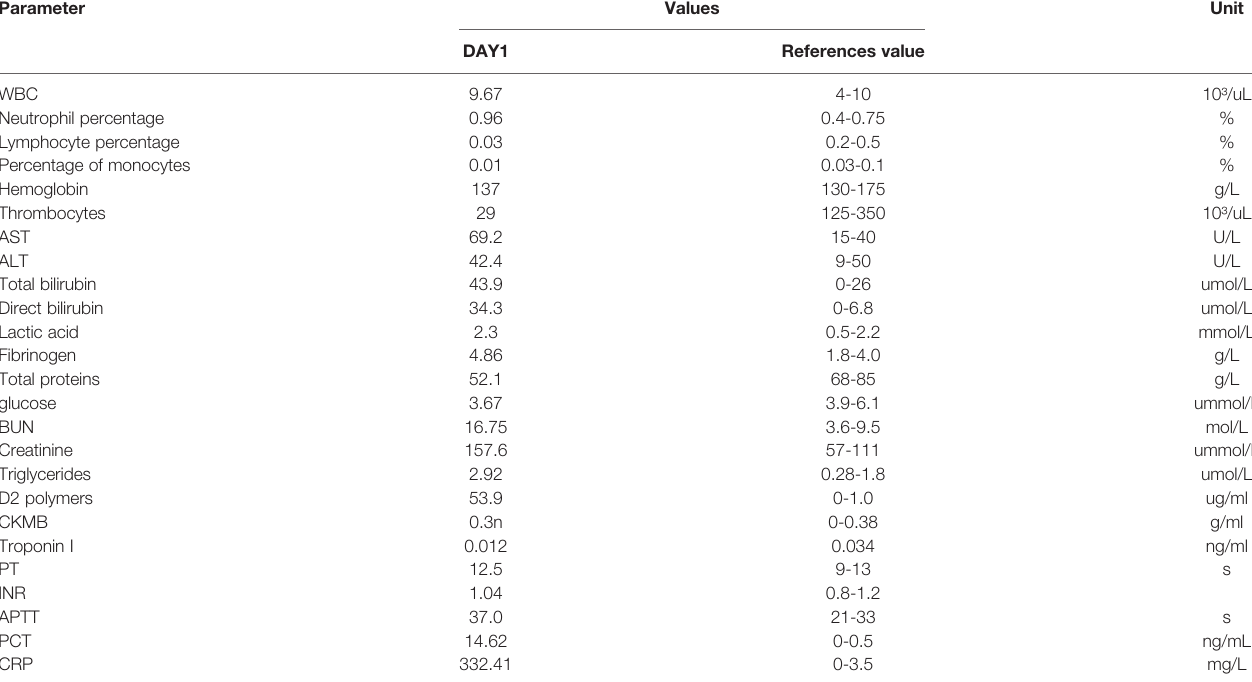
TABLE 1 | The changes in signi fi cant laboratory test results during the whole treatment process.